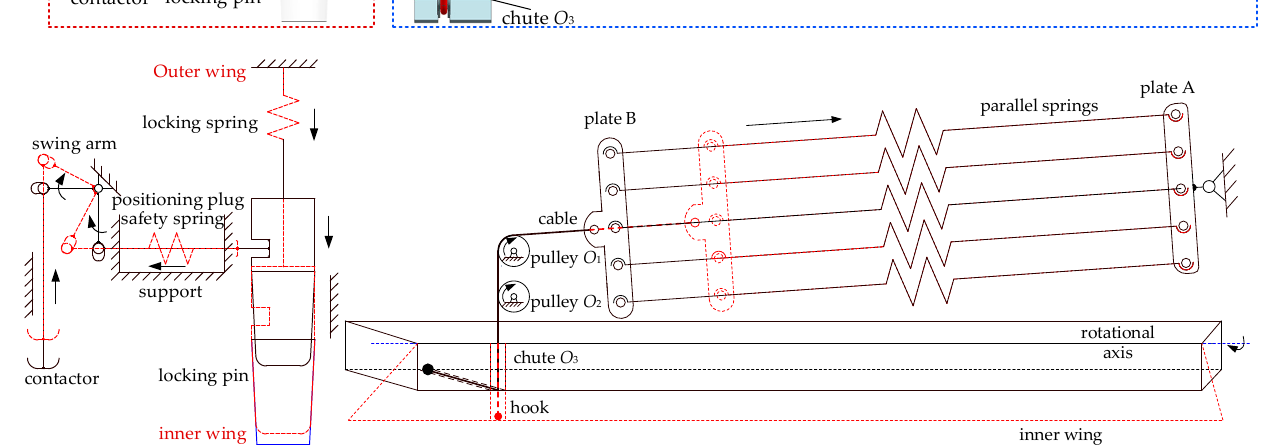
Figure 1. Structure of folding wing.